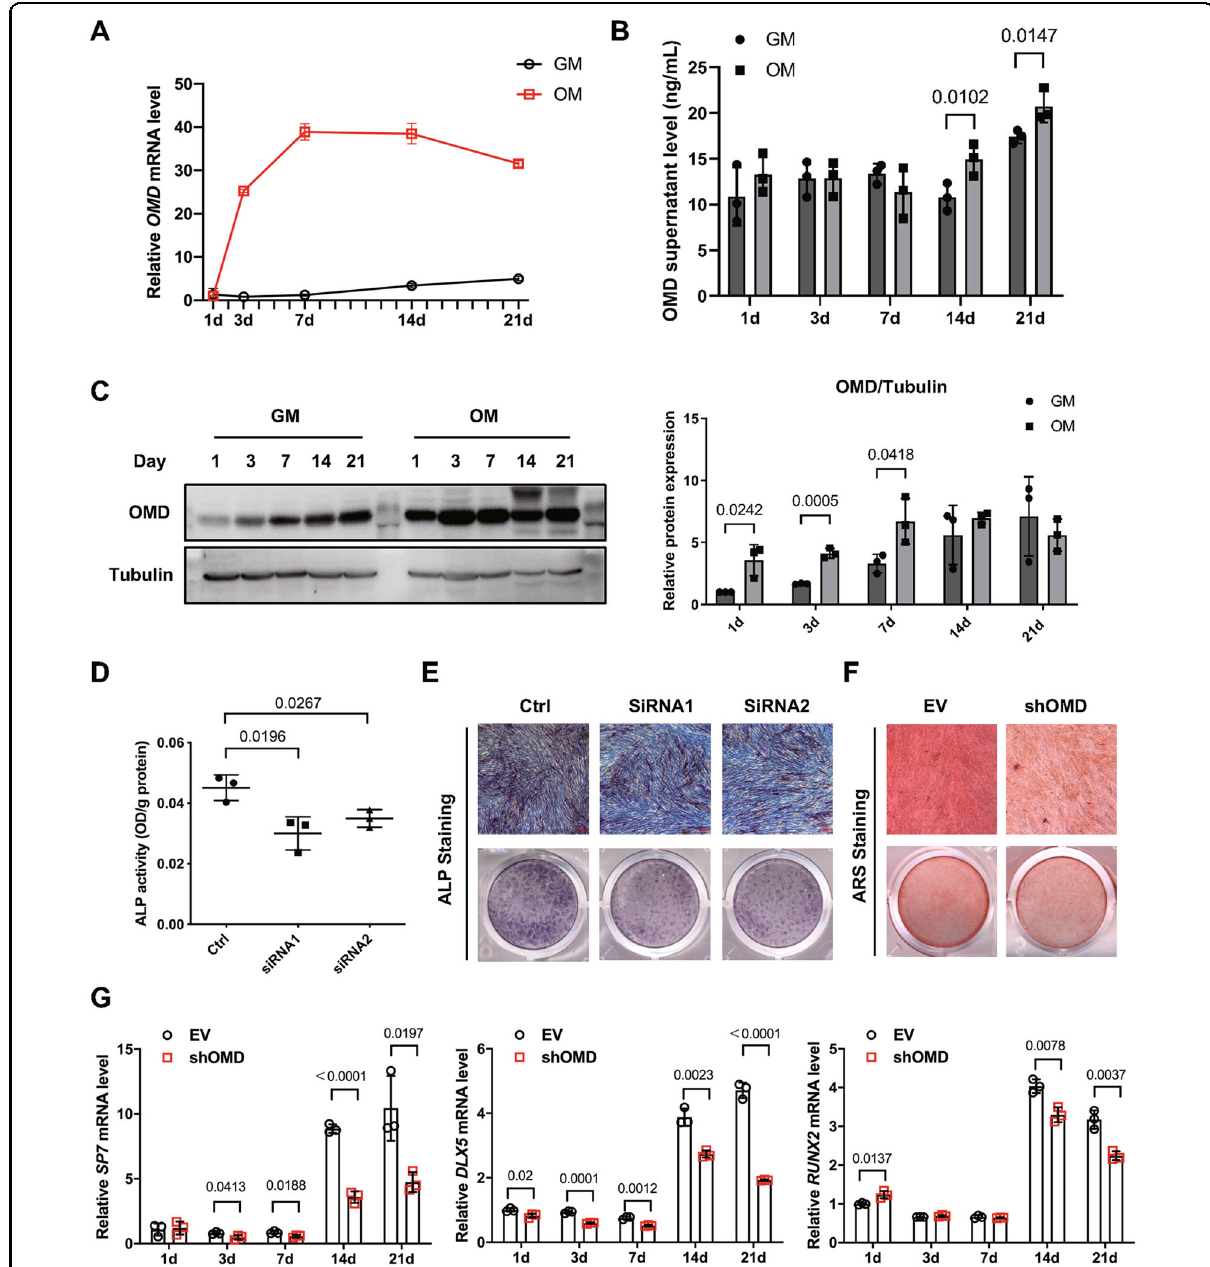
Fig. 1 OMD is essential for the osteogenic differentiation of hDPSCs. A The transcriptional level of OMD in hDPSCs after cultured in growth medium (GM) or osteogenic medium (OM) for 1, 3, 7, 14, 21 days, respectively. B The concentrations of OMD in culture supernatants collected at fi ve time points. C The variation of OMD protein levels in cells cultured in GM or OM and normalized to Tubulin expression by densitometric analysis. ALP activity ( D ) and ALP staining ( E ) of hDPSCs after siRNA transfection targeting OMD and culture with OM for 7 days (200X). F ARS was performed on day 21 of induction after OMD was silenced by shRNA (200X). G The mRNA levels of transcription factors including SP7 , DLX5 , and RUNX2 in hDPSCs infected by lentivirus containing empty vector (EV) or shOMD vector during osteogenic induction. Scale bar: 100 µm. Signi fi cance in difference between two groups were tested by Student ’ s t -test. Data were presented as mean ± OMD facilitates BMP2-induced osteogenesis in vitro and in vivo The extracellular effect of OMD was investigated with recombinant OMD protein. The cytotoxicity assay